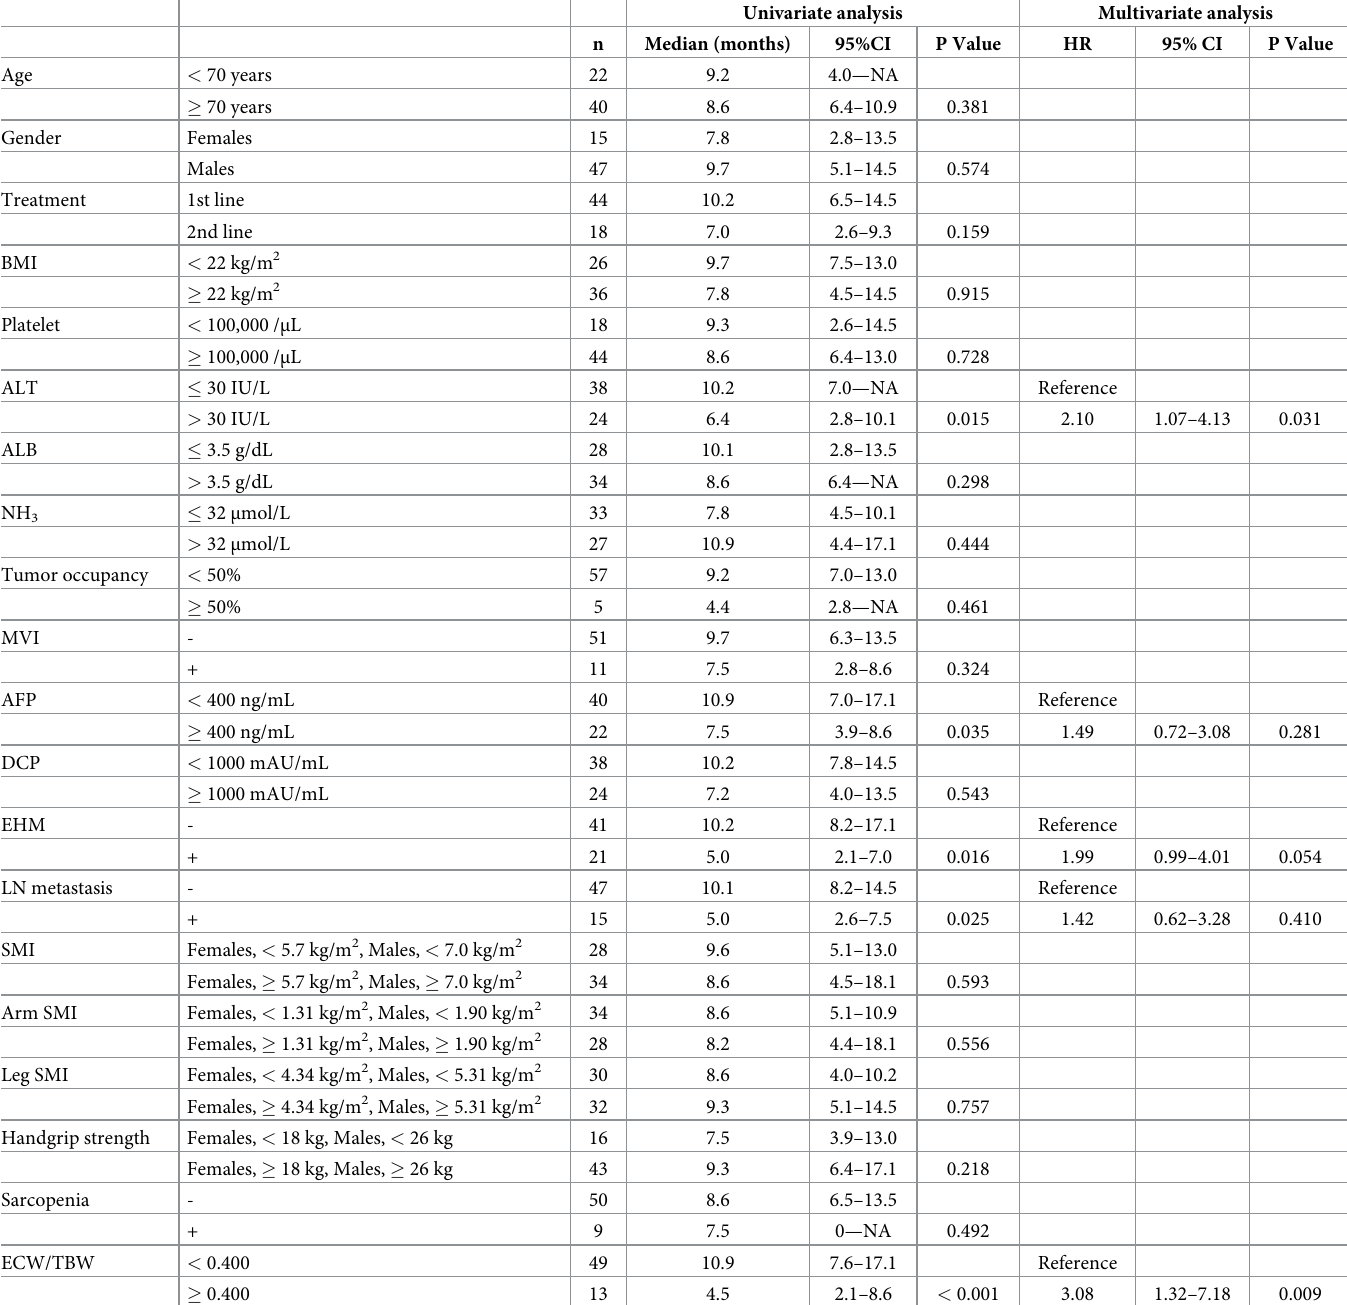
Table 4. Factors associated with post progression survival treated with